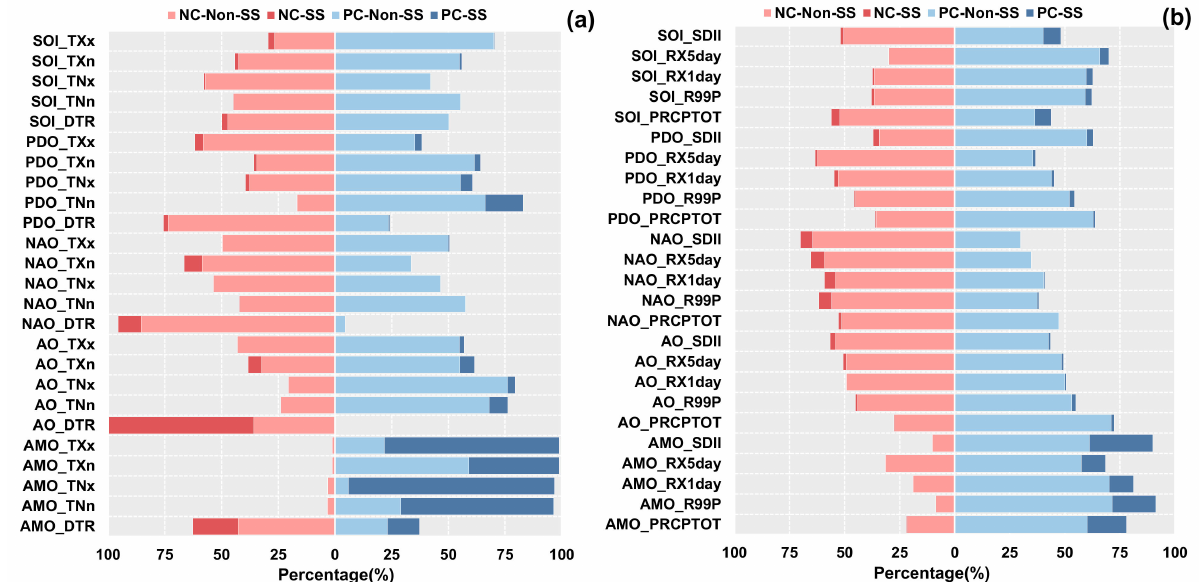
Figure 7. The percentage of areas with significant or non-significant correlation between extreme temperature ( a ) precipita- tion ( b ) and climate indices in the YRB during 1961 to 2020.